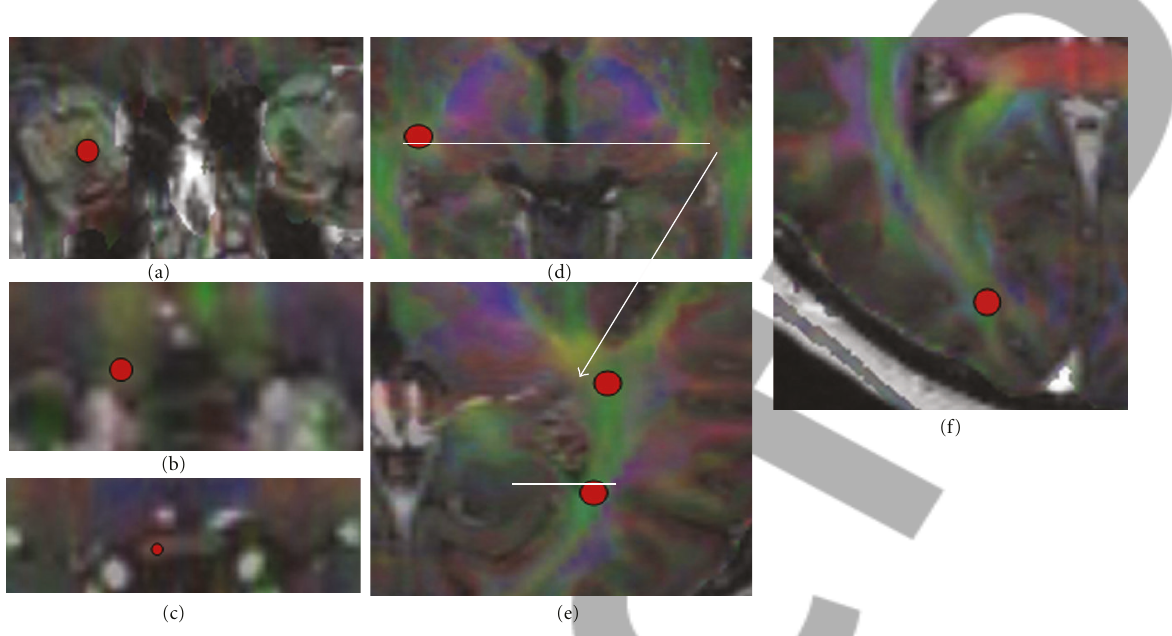
Figure 1: Di ff erent regions of interest (red circles in the right visual pathways) that were used for evaluation of radial di ff usivity (RD) and fractional anisotropy (FA) in glaucoma patients and controls in the left and right visual pathways: intraorbital part of the optic nerve (a), intracranial part of the optic nerve (b), optic chiasm (c), lateral geniculate nucleus (d), and di ff erent sections of the optic radiation (e, f). All regions of interest are drawn in a fused dataset of FA-weighted DTI and 3D-MPRAGE sequences (a–c: coronal slides; d–f: axial slides).